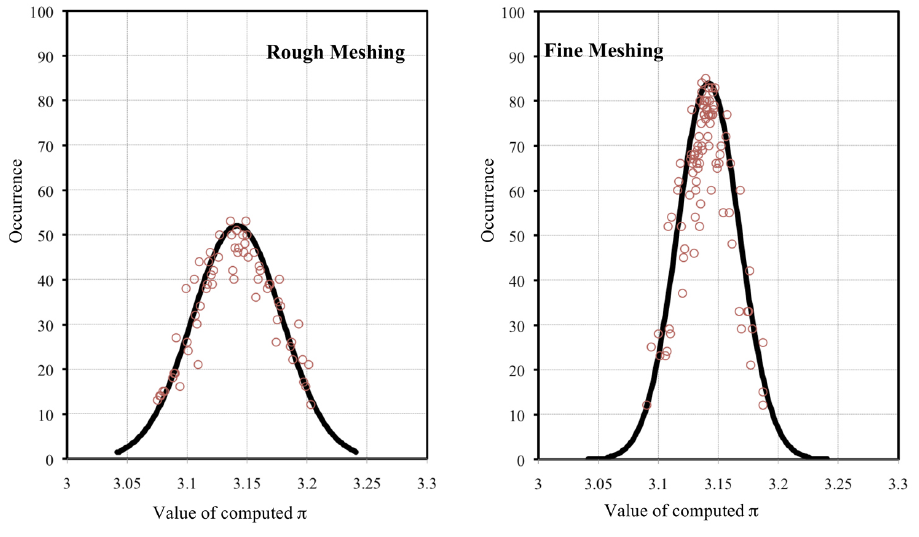
Figure 5. Convergence analysis of the value of π based on the computation